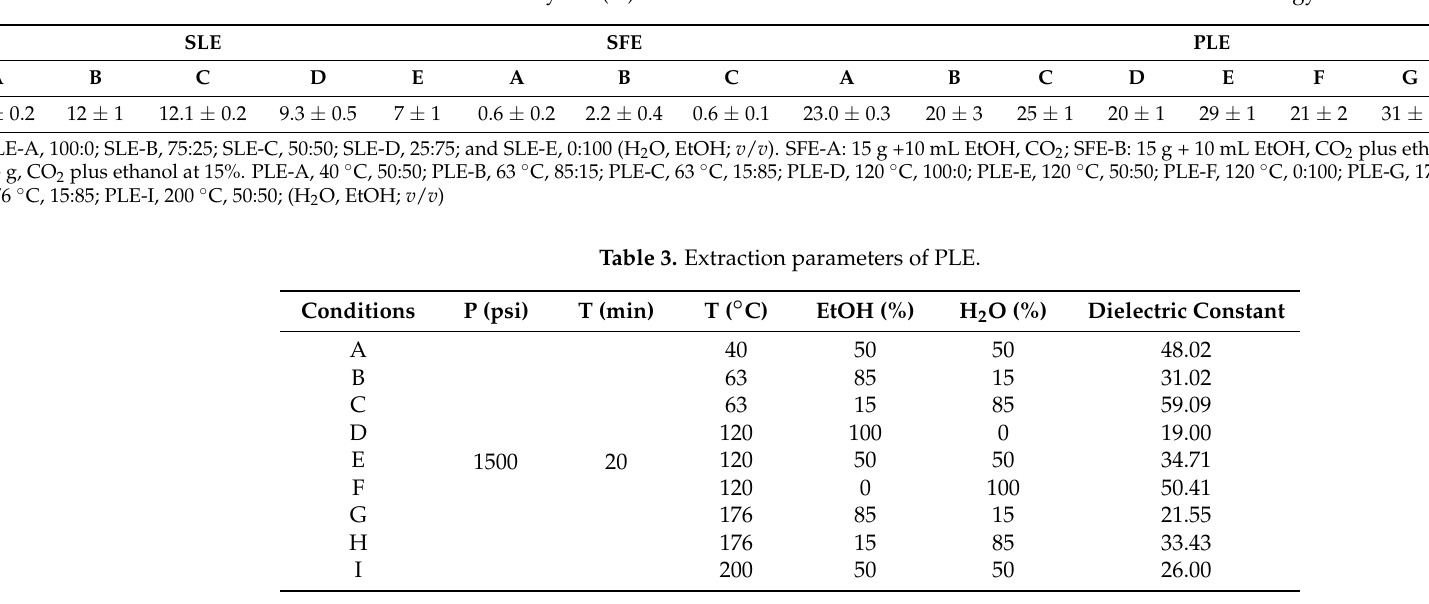
Table 2. Values of extraction yield (%) obtained in the different conditions for each extraction methodology.